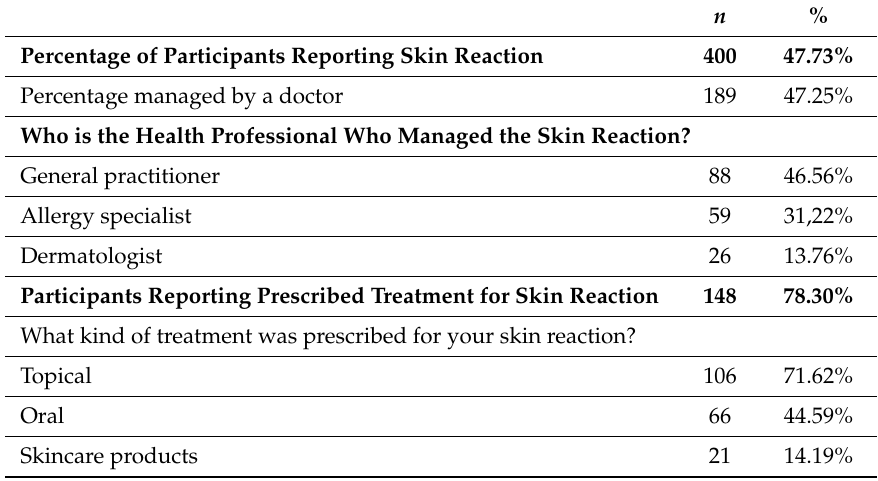
Table 4. Skin reactions associated with